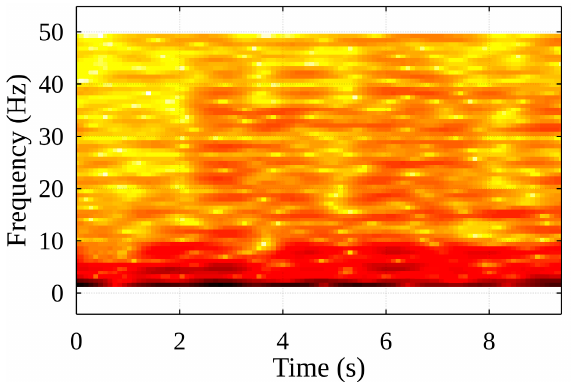
Figure 14. Acceleration of container along X-axis (handling cycle).